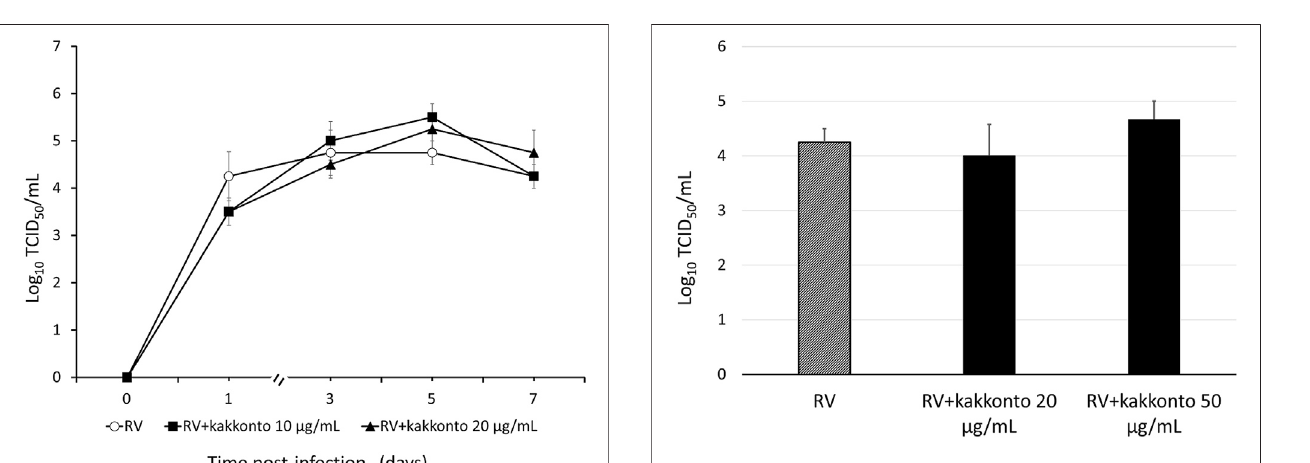
FIGURE 3 | Viral release into supernatants of HNE cells treated with 20 μ g/ml and 50 μ g/ml kakkonto or cultured in medium alone and collected 24 h after RV infection. Results are presented as the mean ± standard error from four